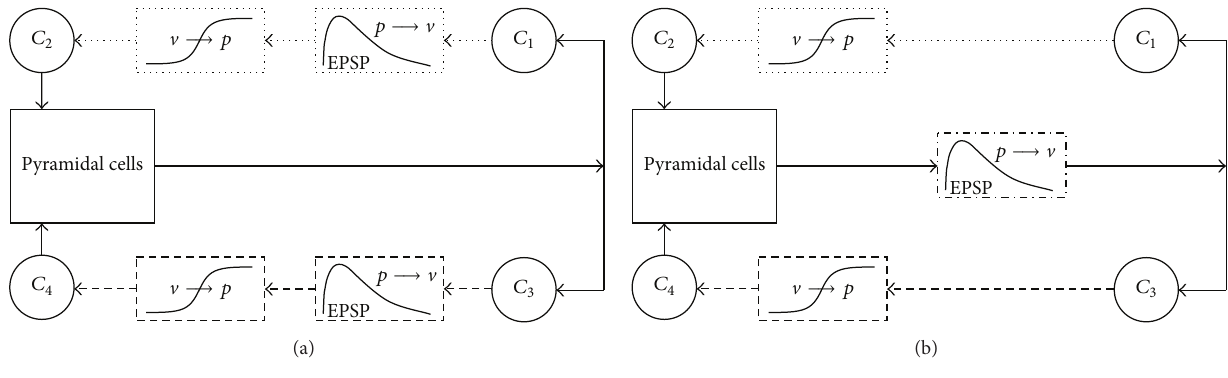
Figure5:Mathematicallyequivalentmodels.(a)Jansenetal.[8]arephysiologicallyaccuratewithonePSPblockforeachinputintoaneuronal subgroup. The same approach was used in Wendling et al. but contradicts the equations. (b) The structure was changed in Jansen and Rit [9] such that two neuronal subgroups share a common PSP block. Cell groups: pyramidal cells (solid lines), excitatory interneurons (dotted lines), and inhibitory interneurons (dashed lines). The EPSP block is shown with dash-dotted lines to indicate that it corresponds to both the excitatory and inhibitory EPSP blocks in